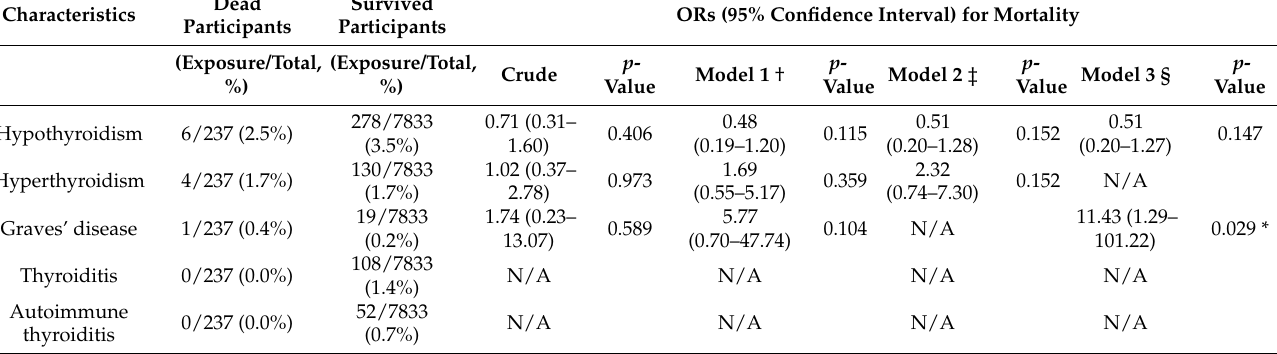
Table 4. Odds ratios of each thyroid disease for mortality in COVID-19